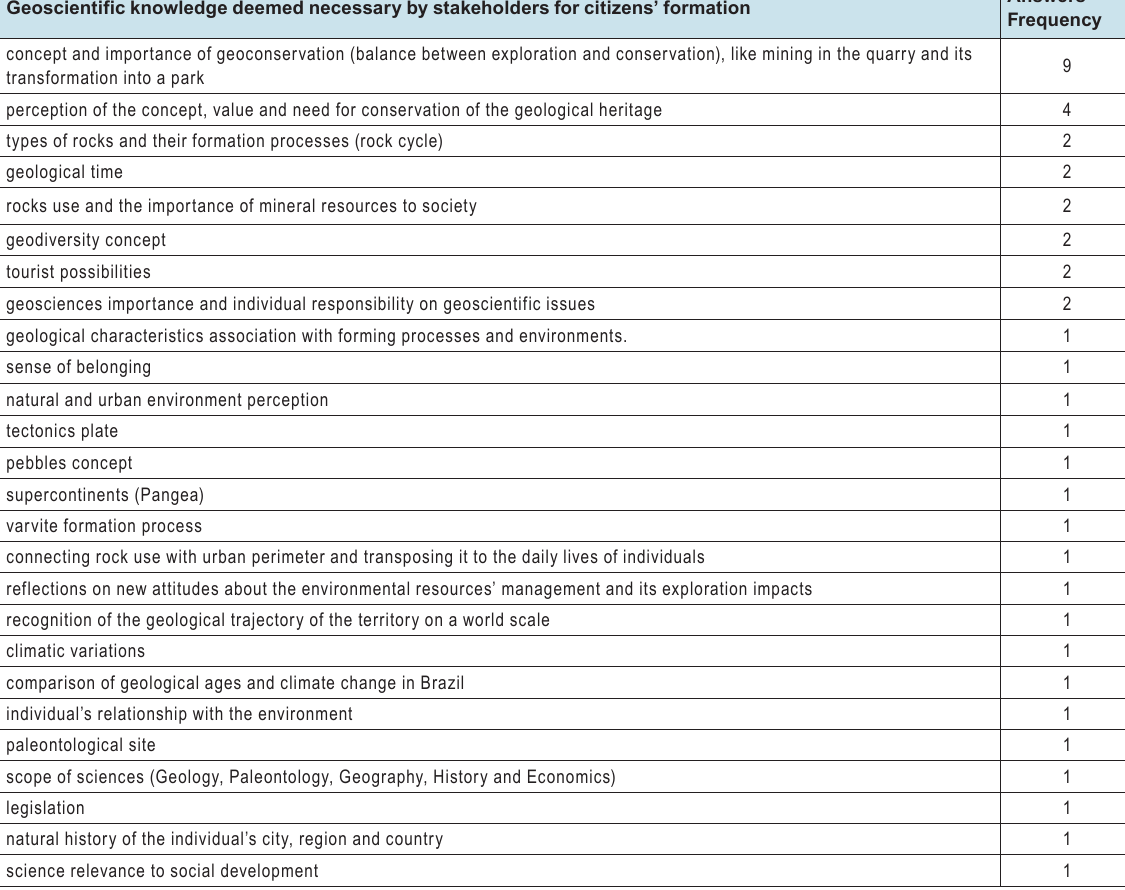
TABLE 3. Geoscientific knowledge deemed necessary by stakeholders for citizens’